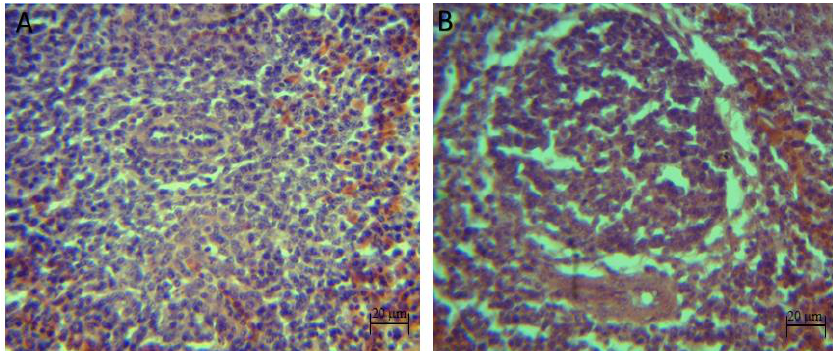
Figure 3. Histopathological injuries in the spleen of broilers chickens challenged with S. typhimurium and C. perfringens . ( A ): Spleen without apparent lesions (control group) (40 × ). ( B ): Lymphoid depletion in the spleen ( S. typhimurium + C. perfringens group) (40 × ).